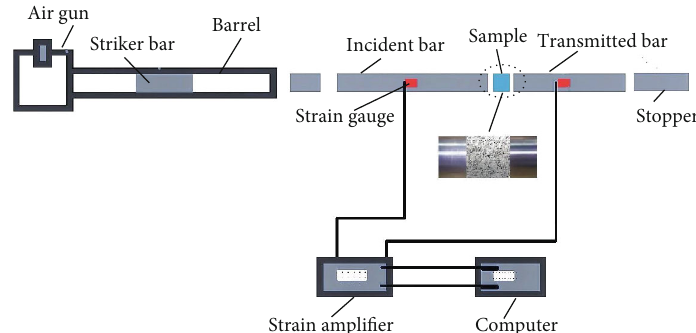
Figure 3: Schematic of the split Hopkinson pressure bar system.